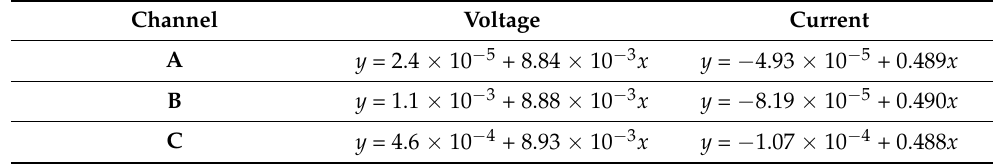
( f ) Figure 7. The measured and processed calibration characteristics: the calibrated values of voltage ( a ) and current ( b ), the residual magnitude errors in three voltage ( c ) and current sensors ( d ) and the relative angle errors for the three voltage ( e ) and current sensors ( f ).